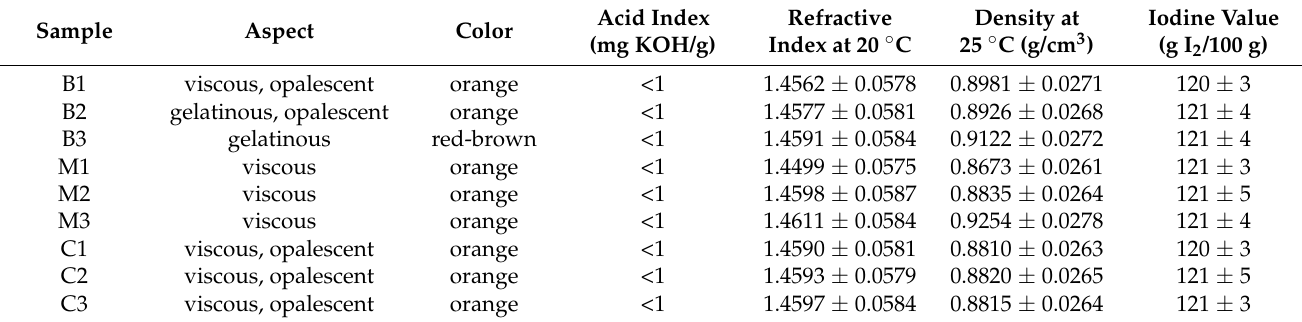
Table 2. The properties of esters via the technologies: bubble-column reactor (B1–B3), microwave heated reactor (M1–M3) and classical reactor